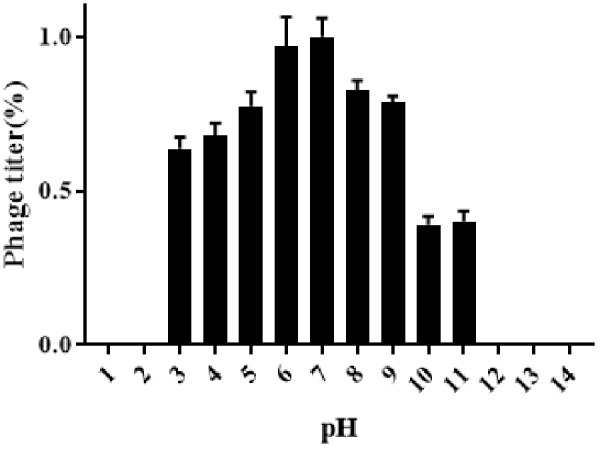
pH stability of phage vB_EaeM_φEap-3. Each data point represents the mean of three independent experiments. Standard deviations are shown as vertical lines. Results are expressed as PFU/mL.